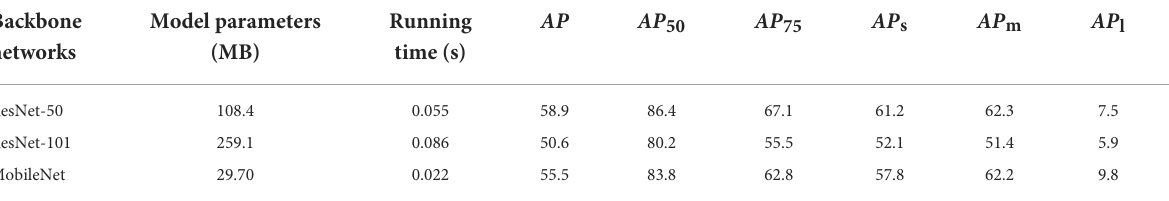
TABLE 3 Comparison of the proposed method based on different backbone